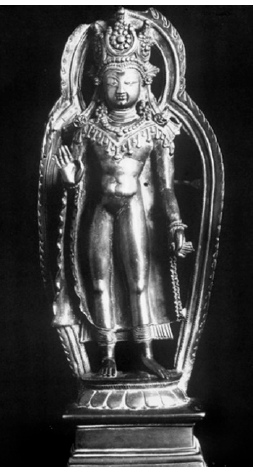
Figure 16. Buddha wearing a crown and a cape with crescent moon and sun symbols, eighth to ninth